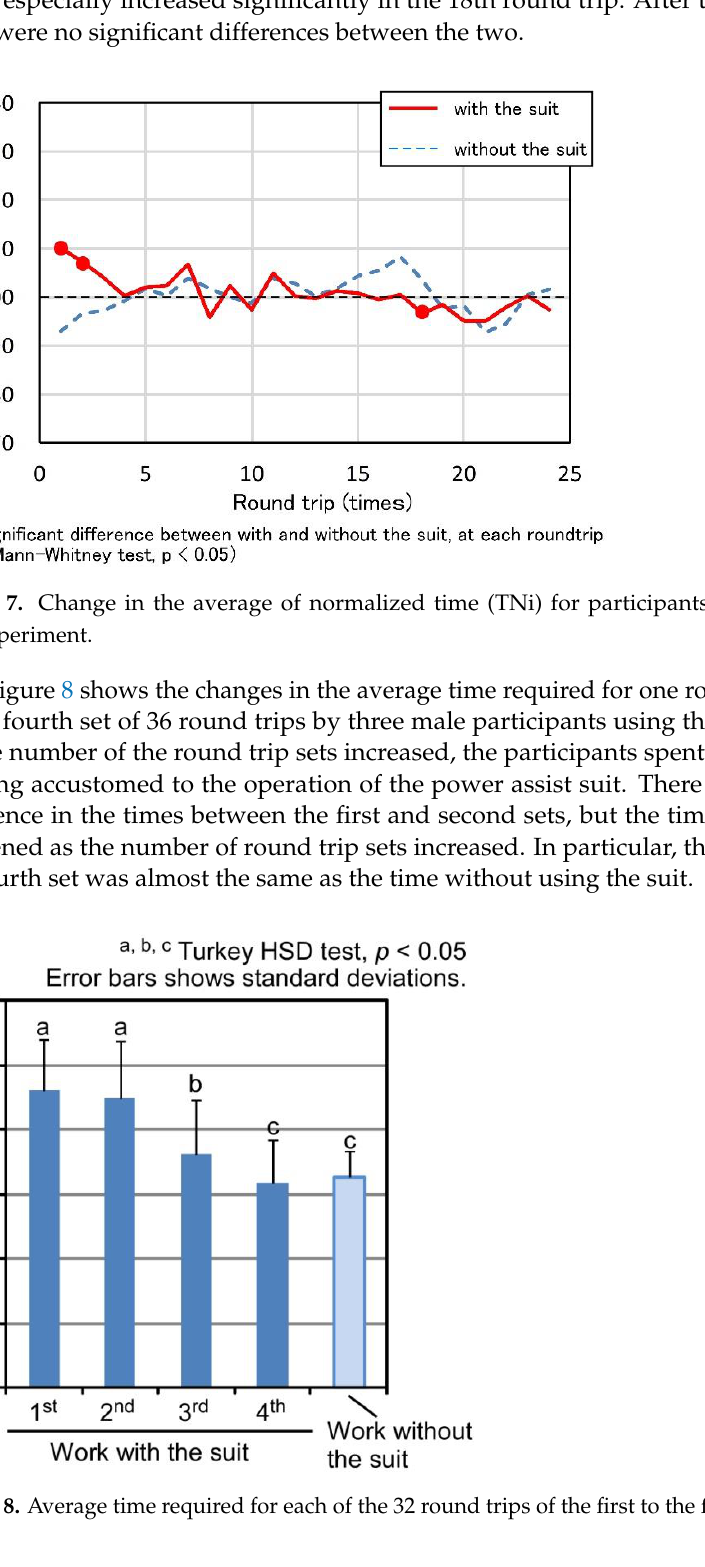
Figure 8. Average time required for each of the 32 round trips of the first to the fourth repeated